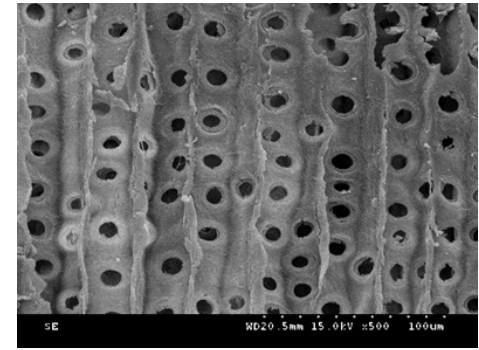
Figure 1: Waterlogged wood SEM